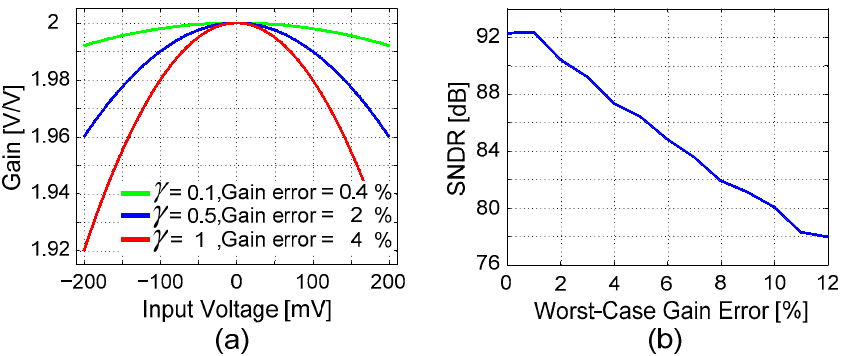
Figure 8. ( a ) Compressive gain nonlinearity and the worst-case gain error of the amplifier. ( b ) Simulated SNDR vs. gain error from the nonlinearity.